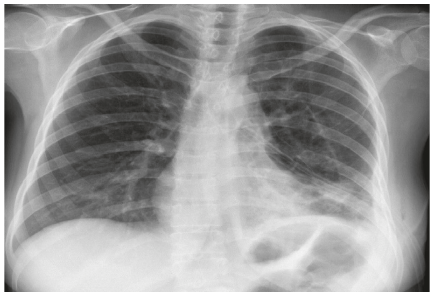
Figure 1: Two pulmonary nodules and basal atelectasis in the left lower lobe with pneumothorax.